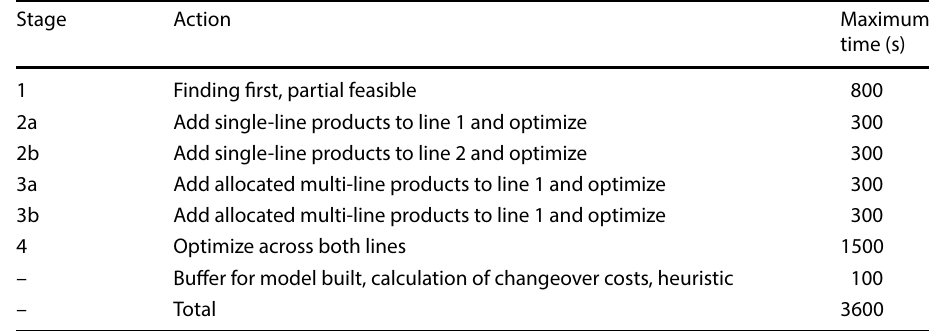
Table 6 Distribution of computation time for 4-stage